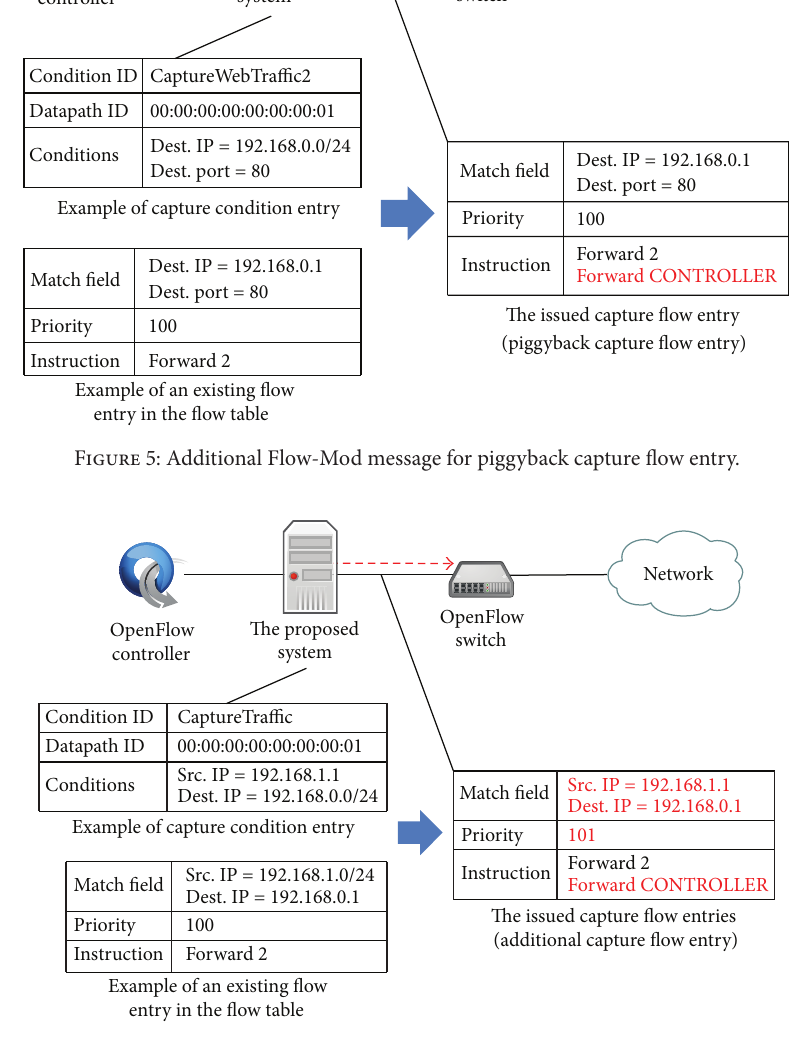
Figure 6: Additional Flow-Mod message for additional capture flow